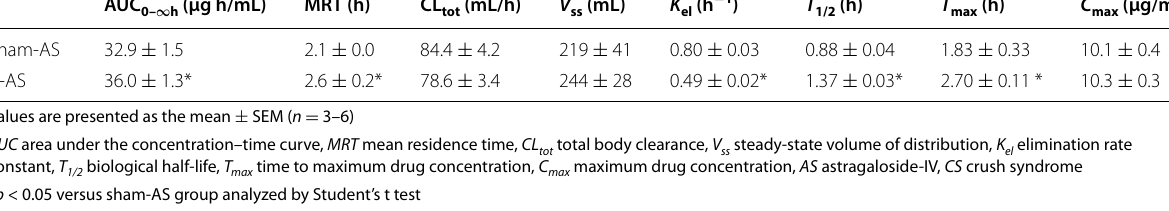
Table 1 Plasma pharmacokinetic parameters of AS in sham and CS rats